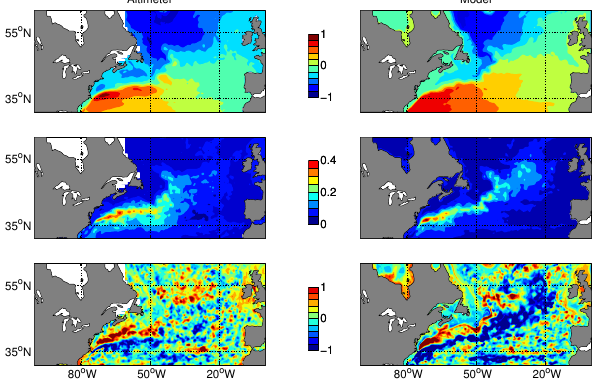
Figure 3. The mean (top), standard deviation (middle) and skew- ness (bottom) of sea surface height (in metres) in the North Atlantic from satellite altimeter measurements (left) and the model hindcast H05 (right) for the period 2003–2009.